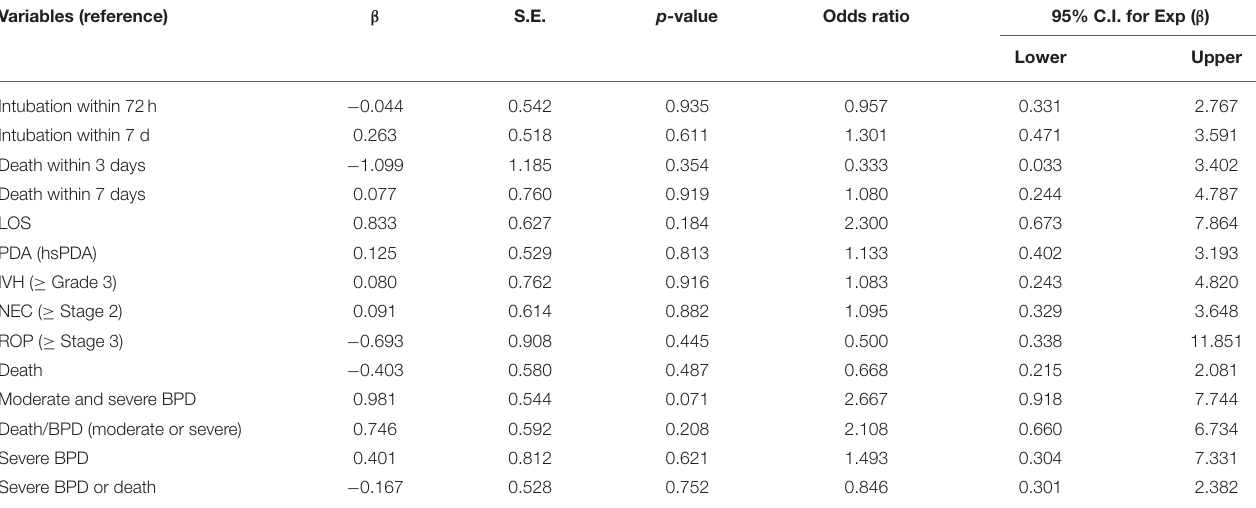
TABLE 4 | The effect of using NIPPV instead of